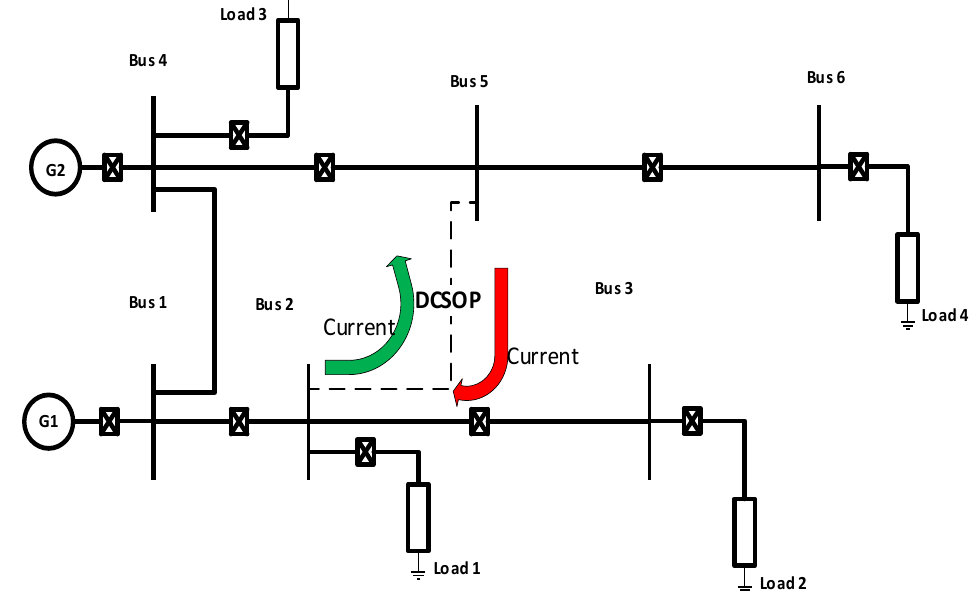
Figure 13. System diagram for testing the control of the current flow direction.